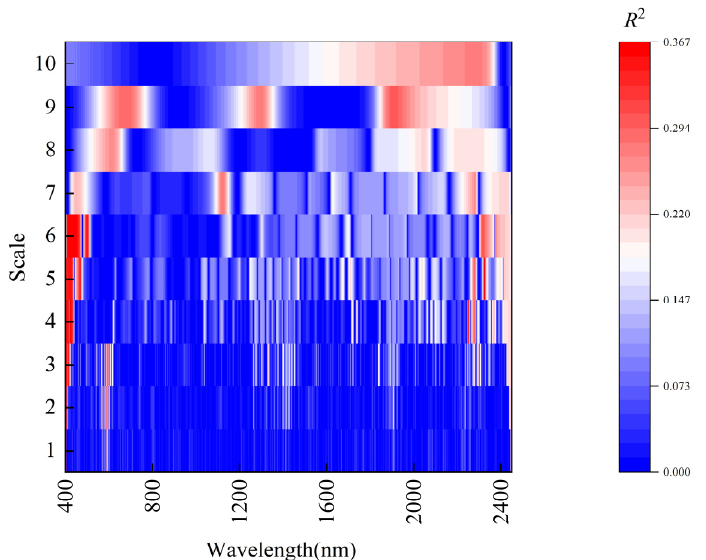
Figure 7. The heat map of the coefficient of determination of the wavelet coefficient and the iron oxide content . Table 3. The number of wavelengths passing the significance test ( p < 0.01) and the maximum cor- relation coefficient for different scale in CWT.